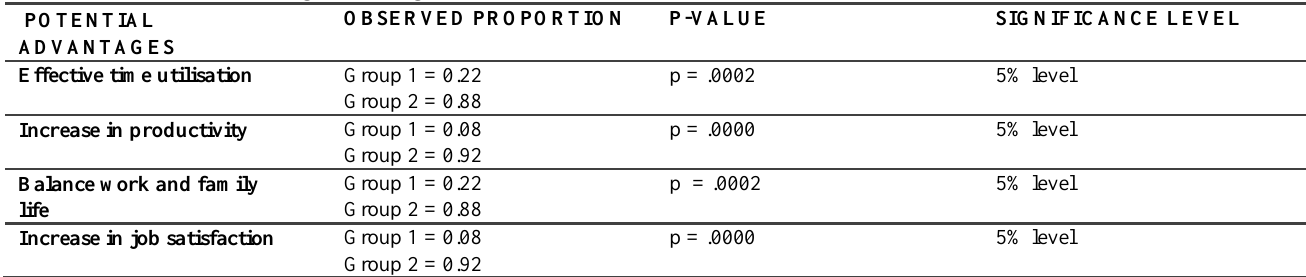
Table 8: Potential advantages of using FWP POTENTIAL